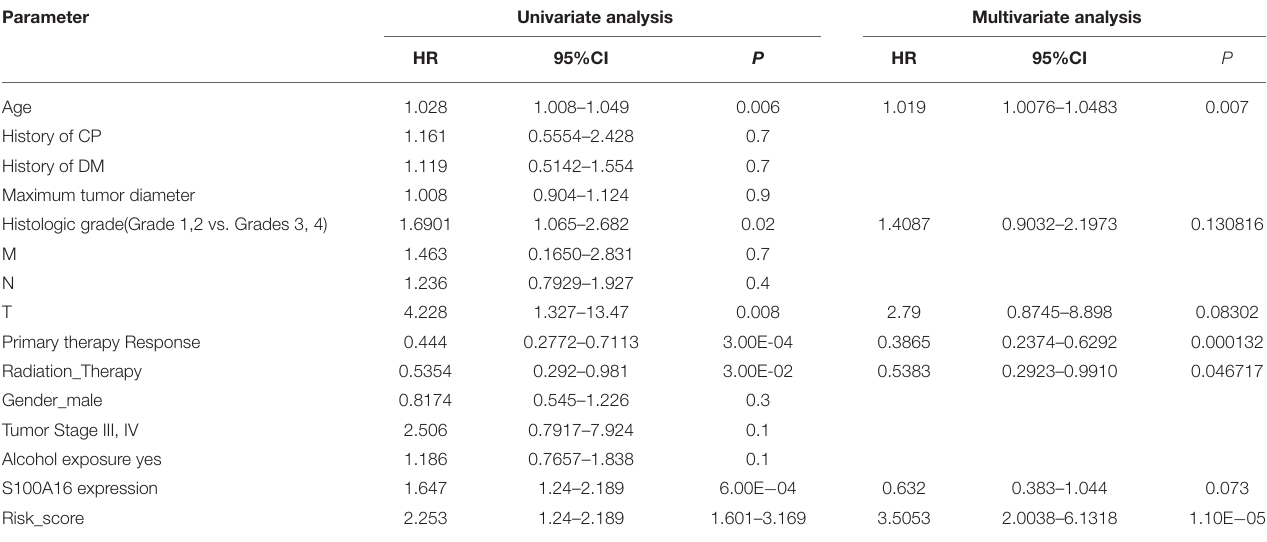
TABLE 1 | Univariate and multivariate analyses of prognostic factors in 182 cases of PDAC. Parameter Univariate